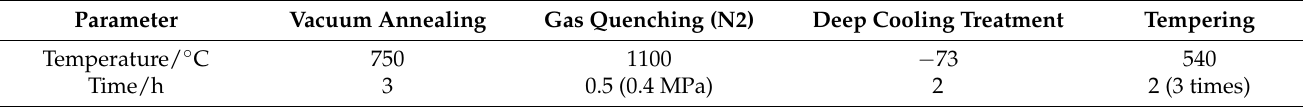
Table 2. Heat treatments of C specimens.